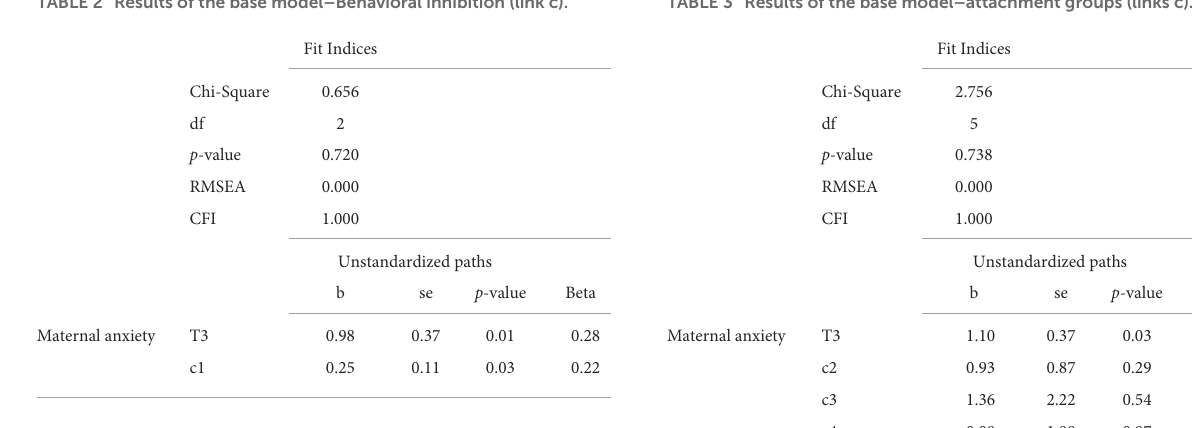
TABLE 2 Results of the base model–Behavioral inhibition (link c). TABLE 3 Results of the base model–attachment groups (links